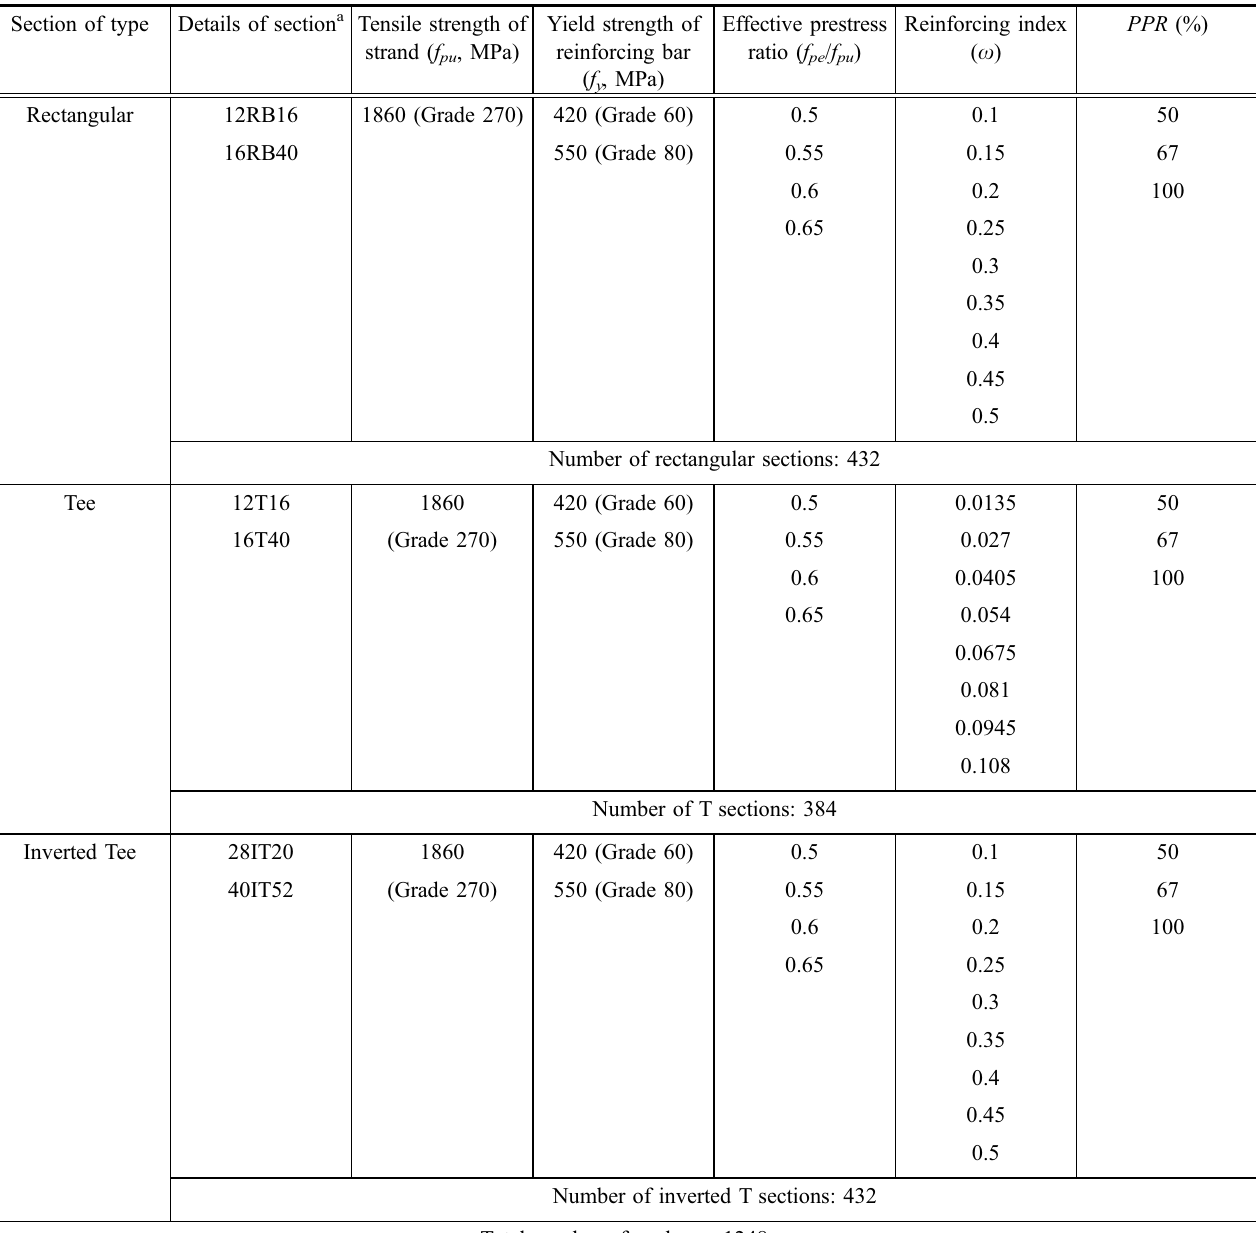
Table 1 Summary of parametric